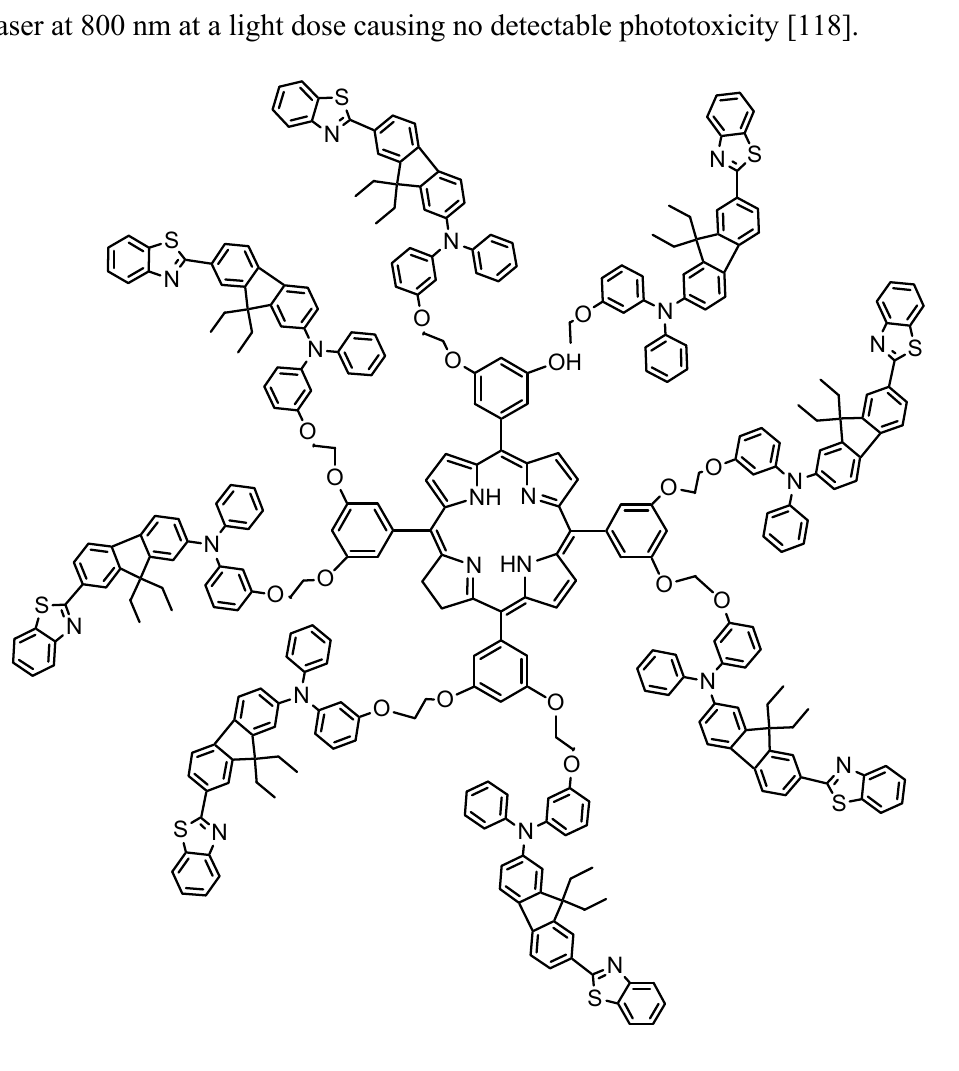
Figure 26. A light harvesting dendrimer having fluorescence resonance energy